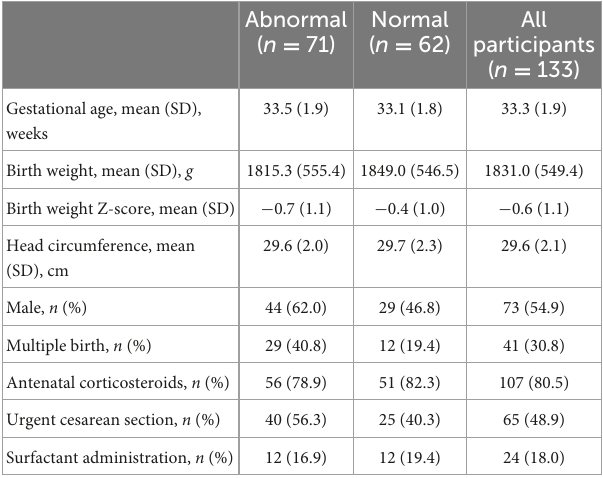
TABLE 1 Neonatal characteristics of the study population according to abnormal or normal neurological examination at term-equivalent age.